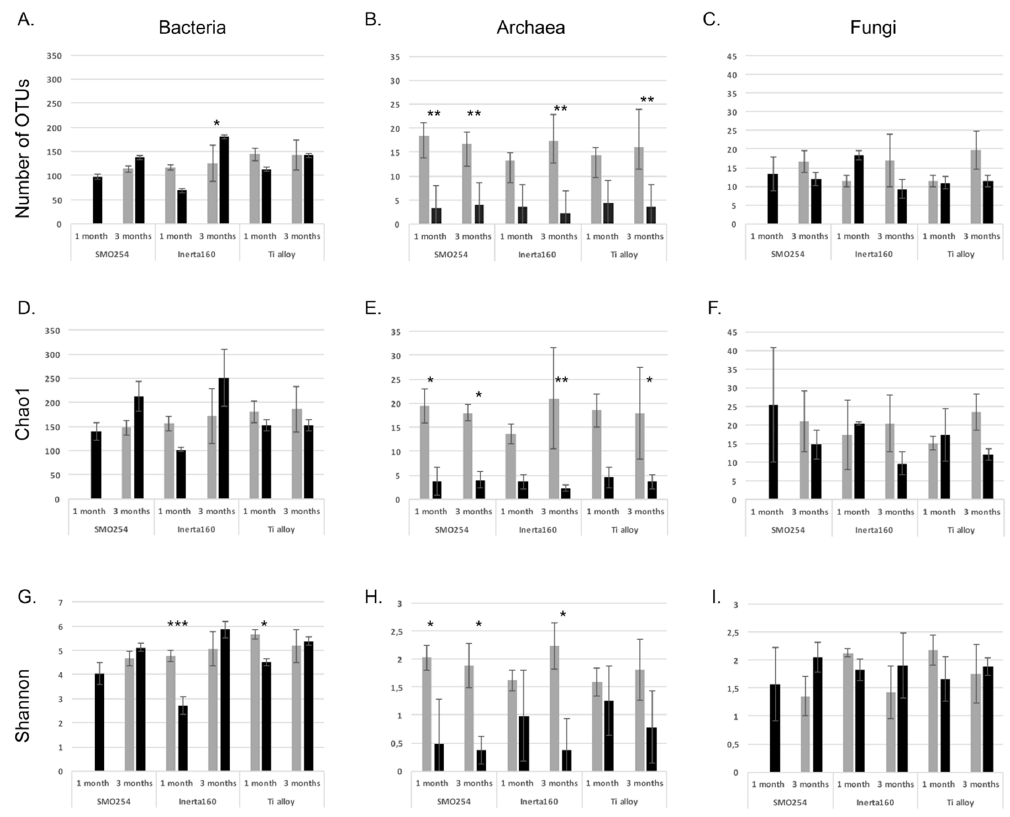
Figure 5. The number of observed Operational Taxonomic Units (OTUs) ( A – C ); the number of estimated OTUs according to the Chao1 richness estimators ( D – F ); and the Shannon diversity index ( G – I ) of the coupon samples. The columns show mean values of three samples based on the normalized number of sequences read per sample, and the error bars indicate the standard deviation. Values calculated for the bacterial, archaeal and fungal data are presented in the left, center and right columns, respectively. Grey columns present non-chlorinated and black columns chlorinated samples. Statistically significantly different sample pairs (non-chlorinated vs . chlorinated) are indicated with stars: * p < 0.05, ** p < 0.005, *** p < 0.0005.